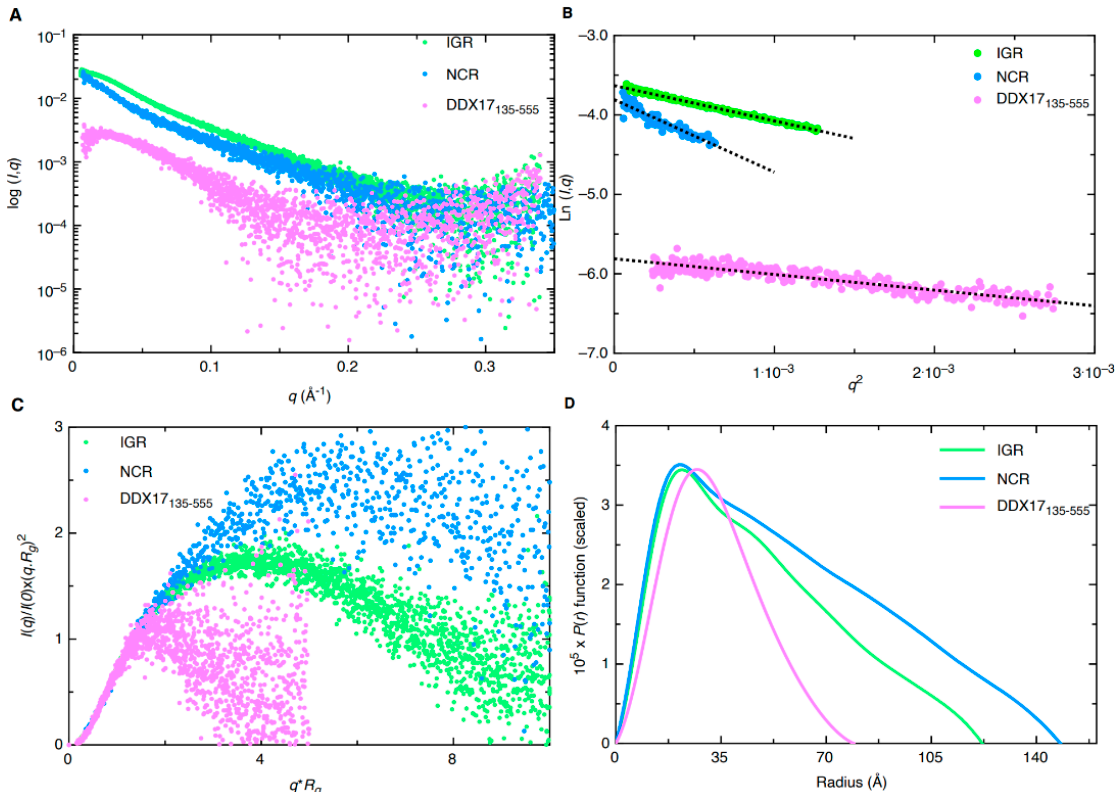
Figure 3. Small-angle X-ray scattering (SAXS) characterization of RVFV RNA (IGR and NCR) and DDX17 135–555 . ( A ) Merged scattering data of RVFV RNA and DDX17 135–555 showing scattering intensity (log I(q)) vs. scattering angle (q = 4 π sin θ / λ ). ( B ) Guinier plots allowing for the determination of R g from low-angle region data and representing the homogeneity of samples. ( C ) Dimensionless Kratky plots (I(q)/I(0)*(q*R g ) 2 vs. q*R g ) of RVFV RNA and DDX17 135–555 , demonstrating extended structures for RVFV RNA and a more compact structure for DDX17 135–555 . ( D ) Pair distance distribution (P(r)) plots for RVFV RNA and DDX17 135–555 which allow for the determination of R g from the entire SAXS dataset, and maximal particle dimension (D max ).